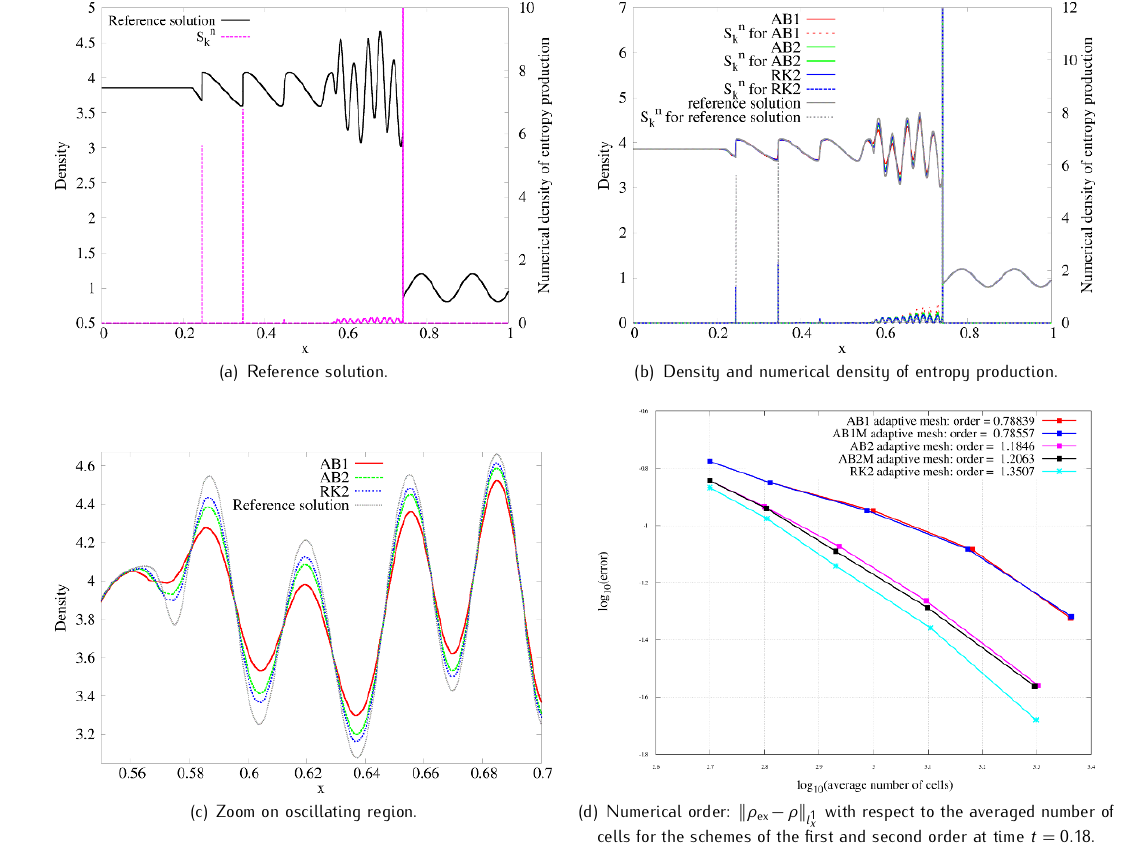
Figure 12. The Shu–Osher test